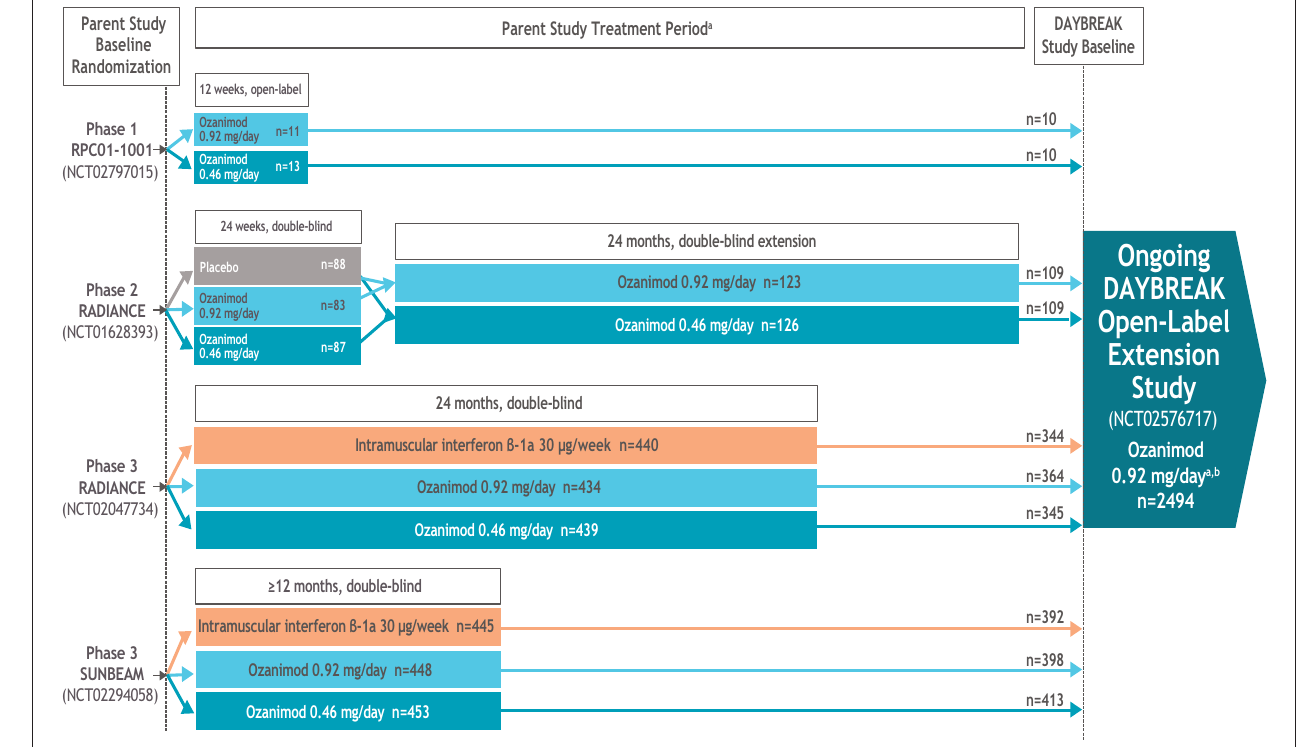
FIGURE 1 | Ozanimod clinical development in RMS program. a In all trials, upon initiation of ozanimod, patients received 0.23mg on days 1–4, 0.46mg on days 5–7, and then their assigned dose of 0.46 or 0.92mg on day 8 and thereafter. All patients entering the phase 2 dose-blinded extension period underwent dose escalation, even if treated with ozanimod in the parent trial, to maintain the blind. b In DAYBREAK, dose escalation was performed for all patients entering from one of the active-controlled phase 3 trials, irrespective of prior treatment assignment (to maintain the blinding in the parent trials); dose escalation was not performed for those entering from the phase 1 or 2 trials, unless the last dose of ozanimod was > 14 days before entering DAYBREAK.